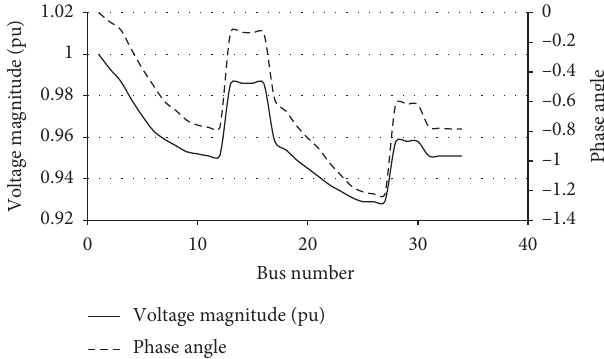
Figure 2: Voltage magnitude and phase for the power system angle before DG installation.